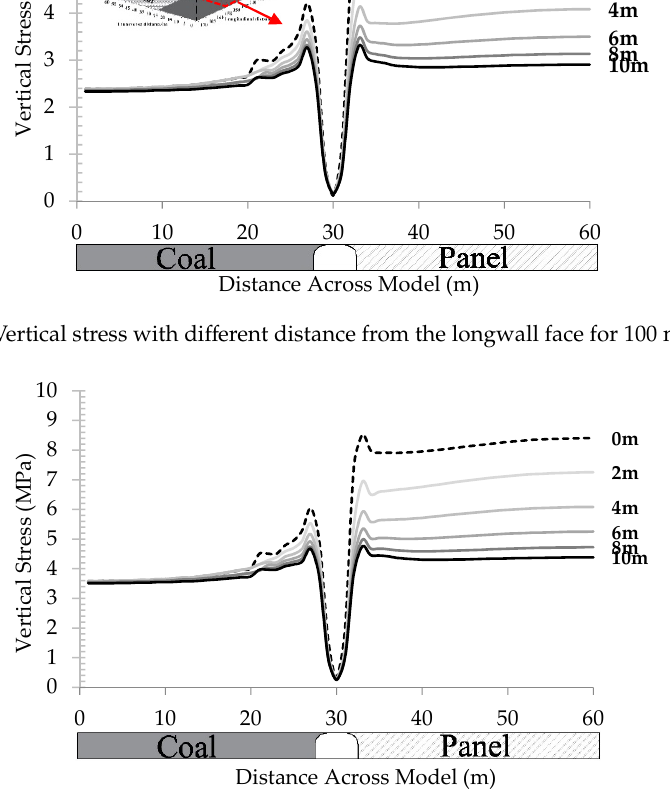
Figure 17. Vertical stress with different distance from the longwall face for 150 m of depth.